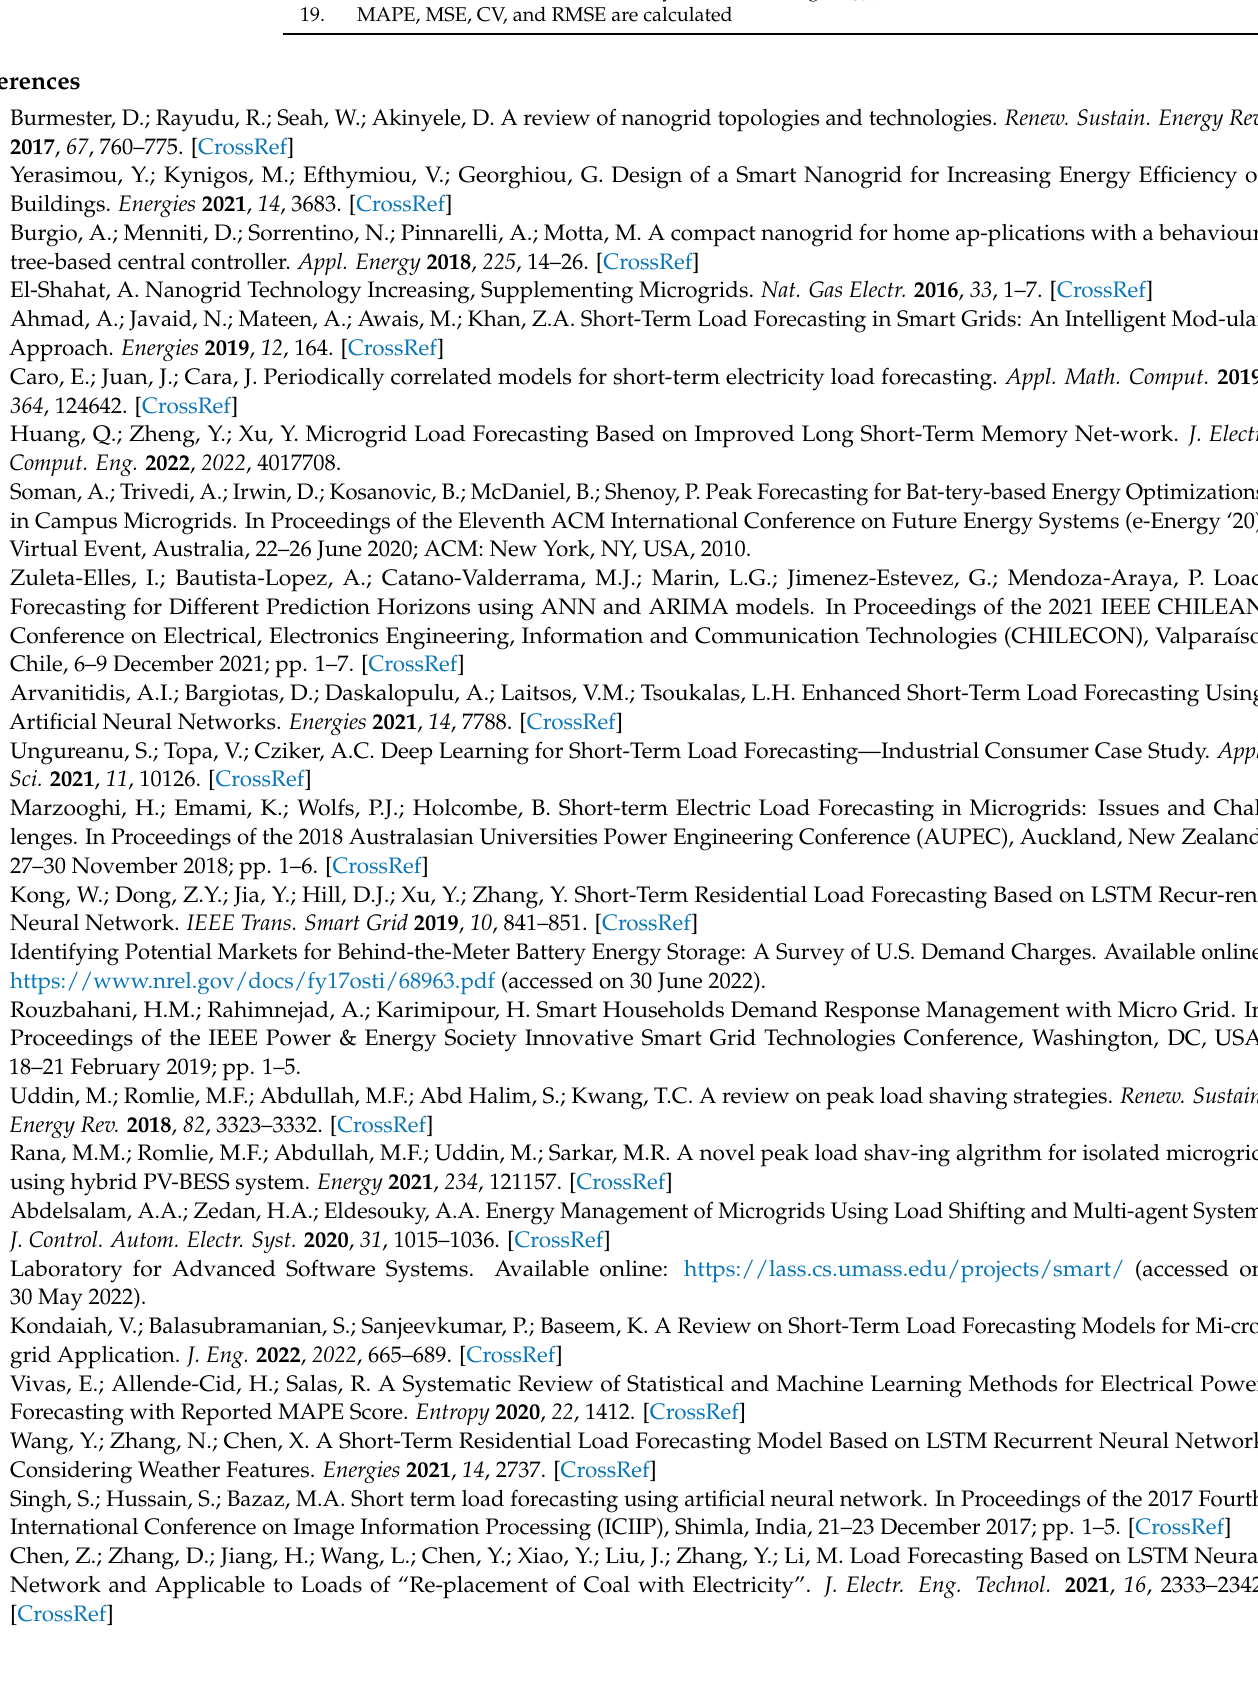
Training time stops and total training time is calculated ( time ) 18. Model tested on test data for hourly load forecasting (L hour ) 19. MAPE, MSE, CV, and RMSE are